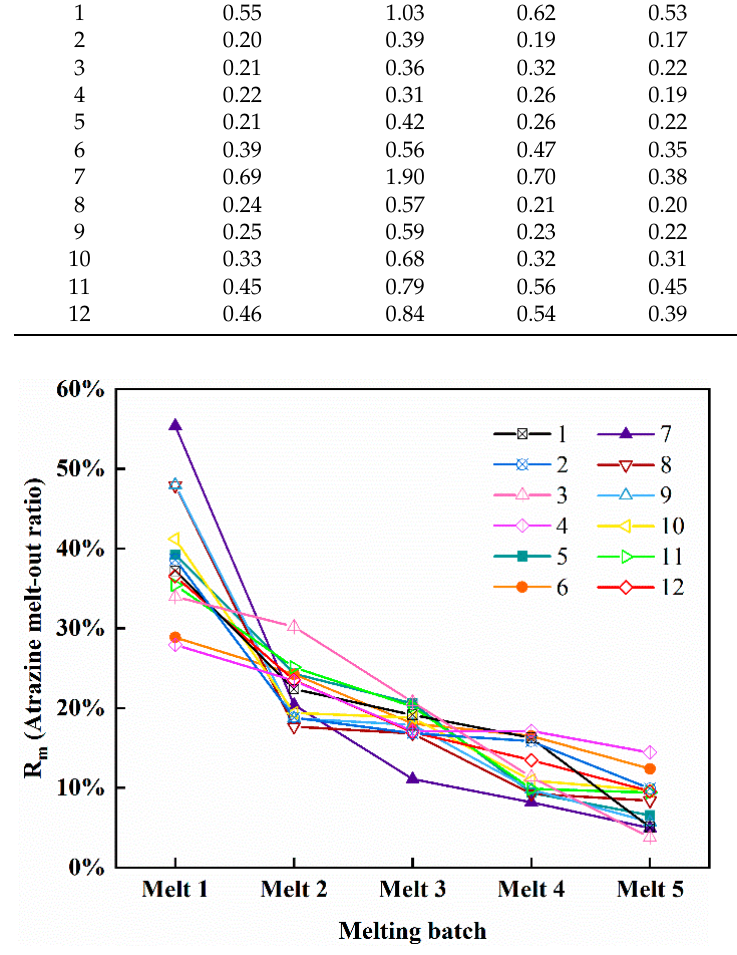
Figure 5. Melt-out ratio (R m ) of atrazine during melting. Table 2. Atrazine concentrations in ice meltwater: averaged value and partial values in each of 20%- fractions during melting.